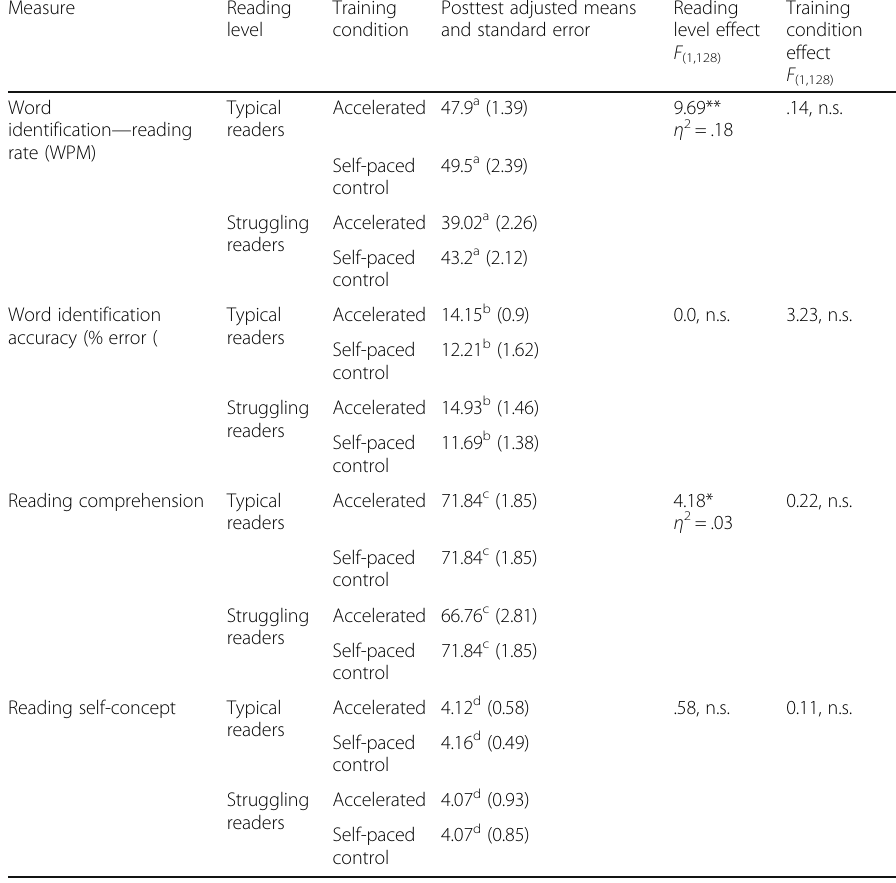
Training Posttest adjusted means level condition and standard error